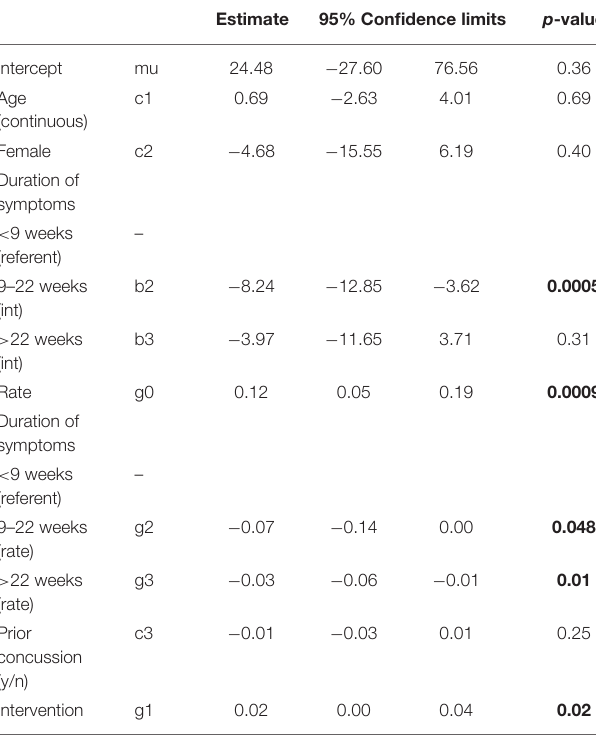
TABLE 2 | Exponential decay model examining the effect of the Sub-Threshold Exercise Program (STEP) on concussive symptoms over time (Health Behavior Inventory, or HBI), adjusted for age, sex, duration of time since injury and history of concussion, Seattle WA